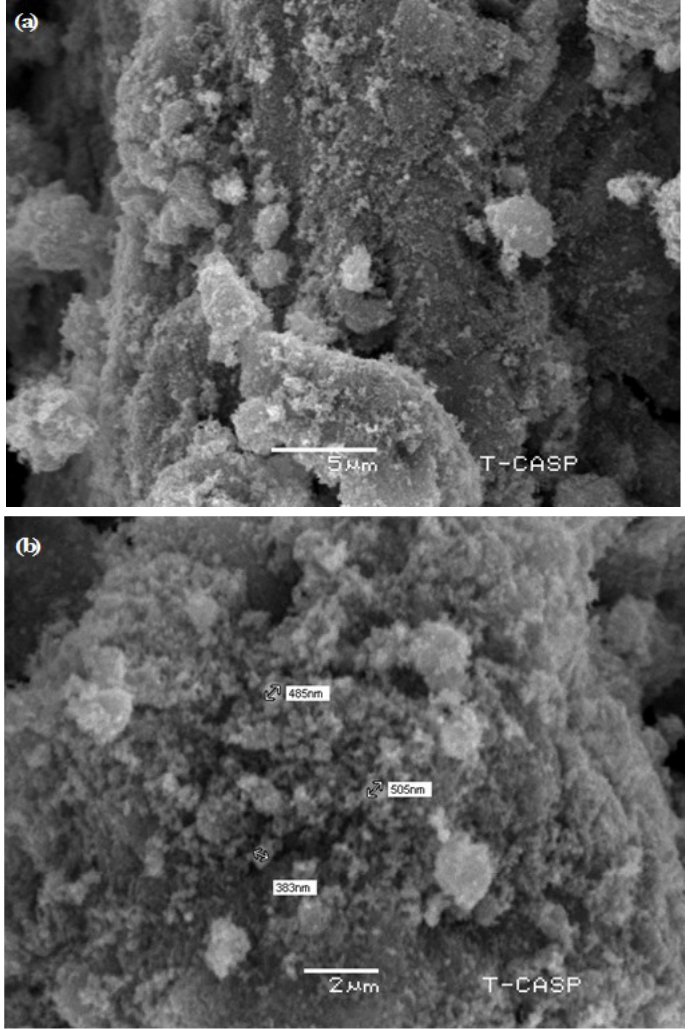
Figure 5. ZnO nanoparticles photoanode prepared using spin coating with magnification: ( a ) 5 µ m and ( b ) 2 µ